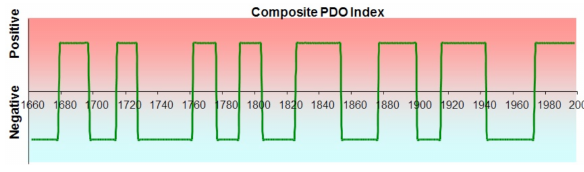
Figure 4. Composite PDO reconstruction from multiple paleo records.